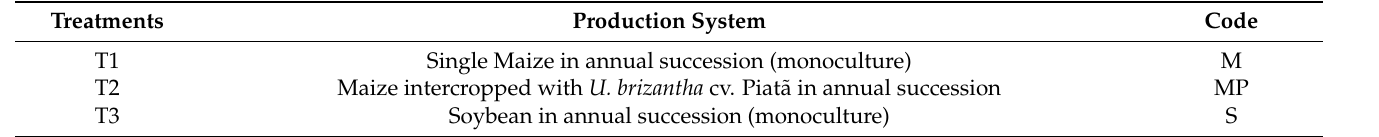
Table 2. Treatments